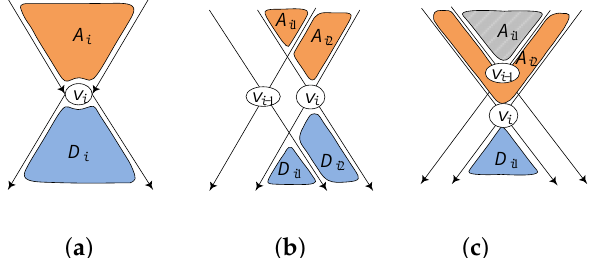
Figure 2. The relationship between different hop-nodes, where ( a ) v i is the first node, ( b ) v i − 1 (cid:54) (cid:32) v i and v i (cid:54) (cid:32) v i − 1 and ( c ) v i − 1 (cid:32) v i